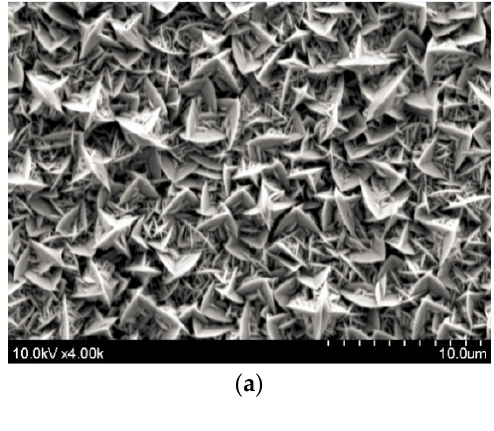
Figure 4. Cont. Figure 4.